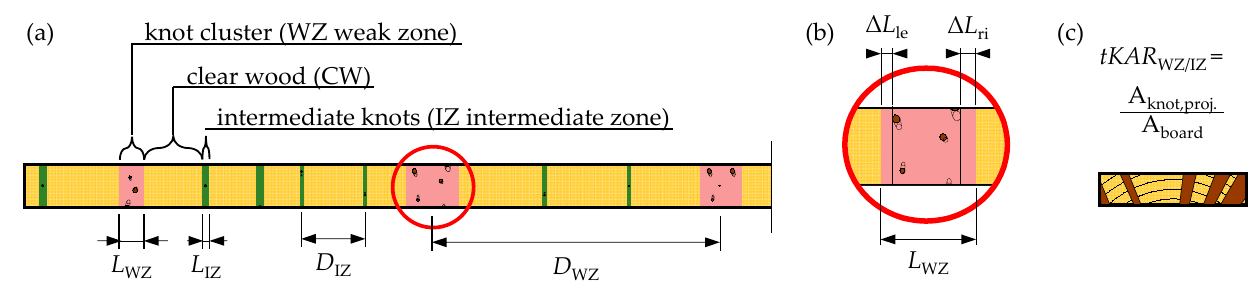
Figure 4. Definition of geometric parameters ( a ); detail of the length of knot zones ( b ); definition of tKAR ( c ).